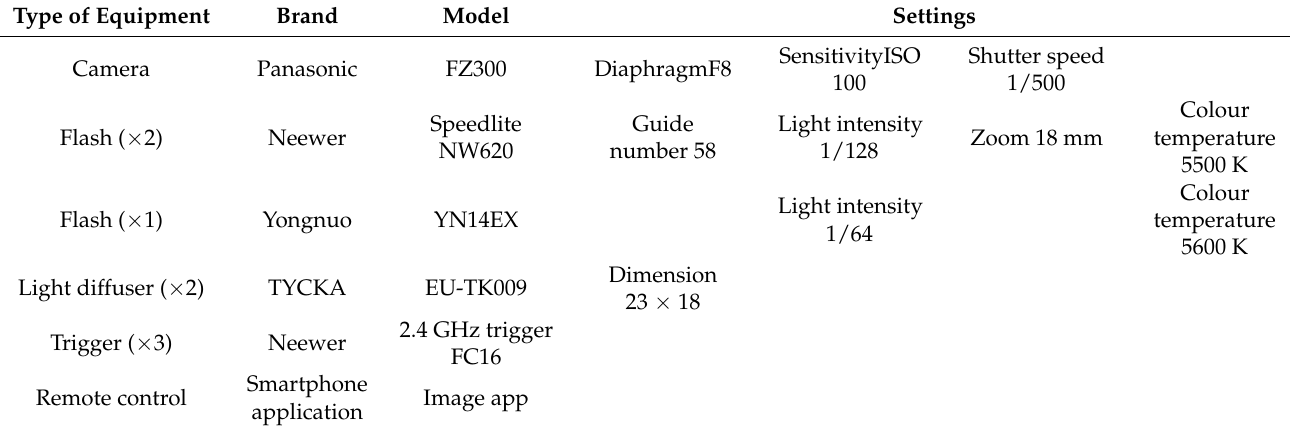
Table 1. The characteristics of the used equipment and the relative settings. The description of both equipment and settings used in the photo shooting are fundamental to guarantee the repeatability of the study and to allow the comparison of the images with those obtained using different